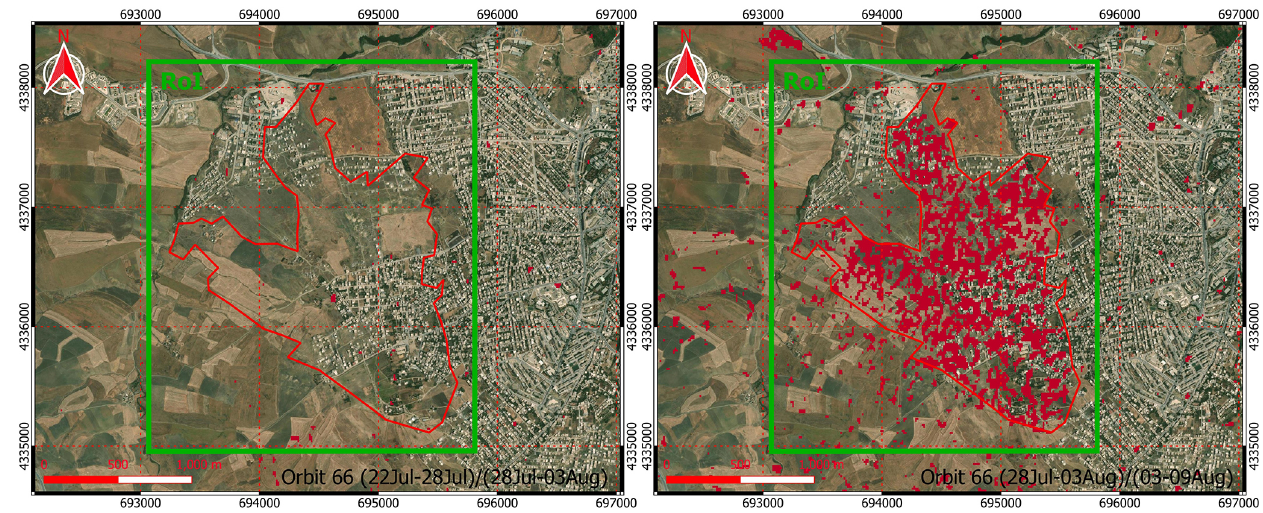
Figure 13. Pre-event coherence ratio (left panel), co-event coherence ratio (right panel), Sentinel-1 orbit 66. The green box indicates the scope of the RoI, and red spots represent significant changes of coherence in the landslide region (QGIS, ESRI World Imagery basemap).